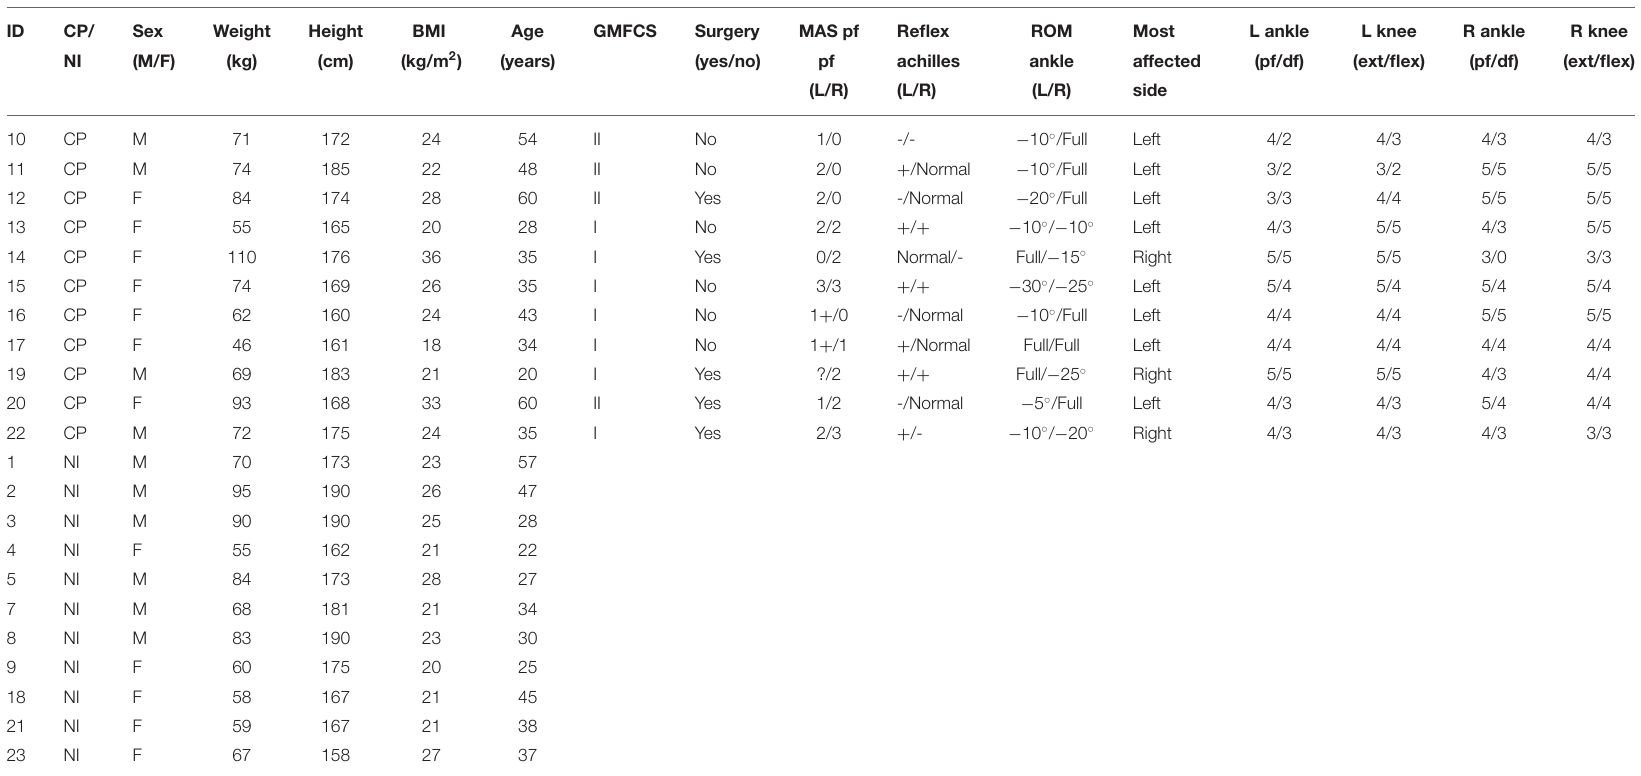
TABLE 1 | Subject